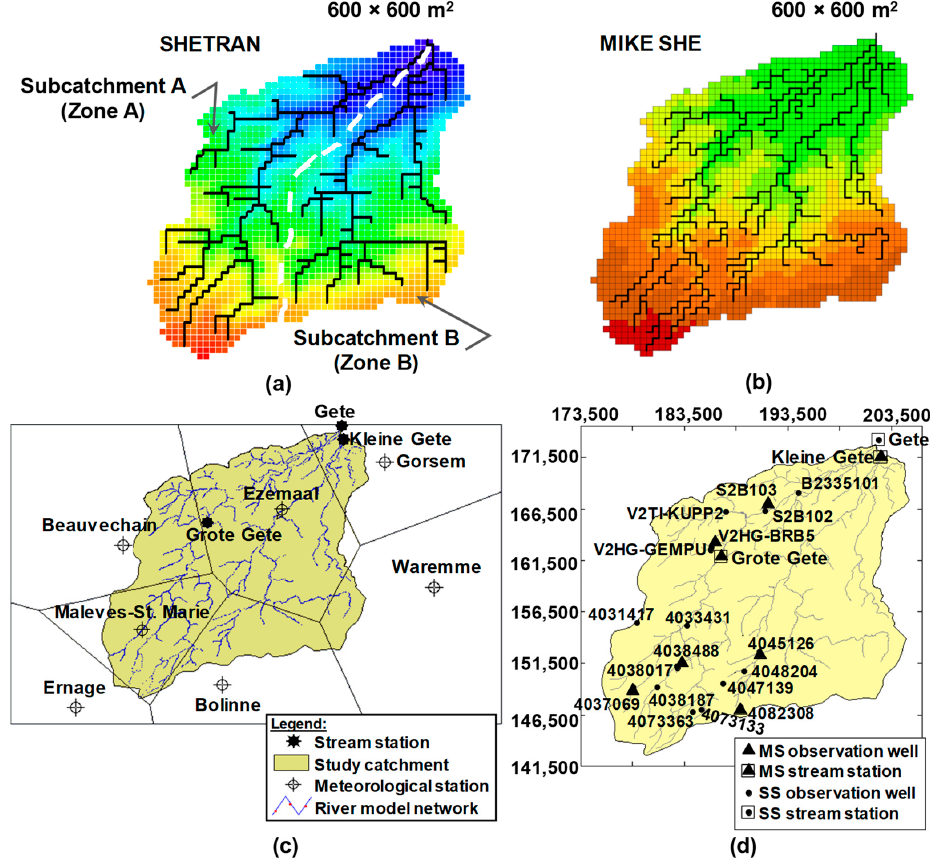
Figure 3. 600 × 600 m 2 model river networks for ( a ) SHETRAN and ( b ) MIKE SHE; ( c ) distribution of rainfall stations used in the modelling and associated Thiessen polygons (after Vázquez [9]); and ( d ) location of the calibration and evaluation stream gauging stations and observation wells (after Vázquez [9]). Topographical colour scales are different in ( a , b ) owing to the use of different software tools (accompanying the SHETRAN and MIKE SHE codes) to create the plots. Plot ( a ) shows the water divide (white dashed line) that determines subcatchments (zones) A and B that were considered for the spatial calibration of some hydrogeological parameters. MS = multi-site model performance validation test; SS = split-sample model performance validation test. Coordinates system: Lambert conformal conic for Belgium.